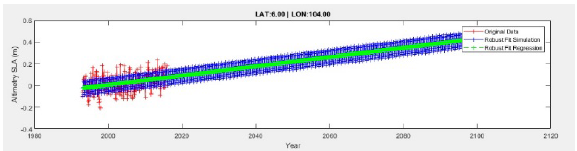
Figure 8. Projected sea level trend at a selected coordinate in the Terengganu coastline using robust fit regression in the years 2040, 2060, 2080 and 2100 Figure 9 represents the distribution map of the sea level rise for